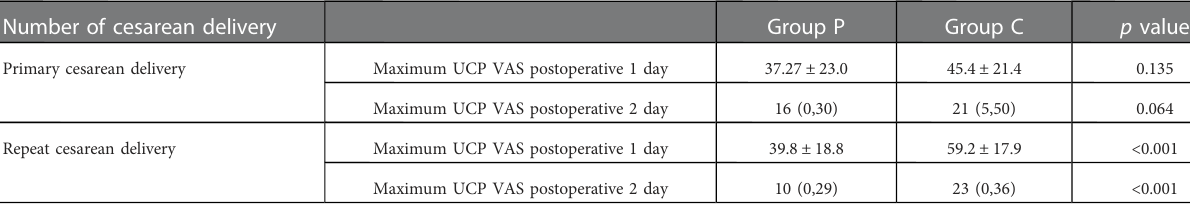
TABLE 4 Subgroup analysis for primary and repeat cesarean delivery on maximum UCP on postoperative days 1 and